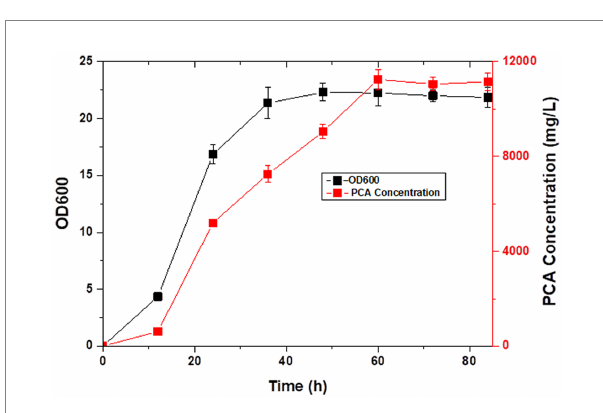
FIGURE 7 PCA production in LDPCA-6 during fed-batch